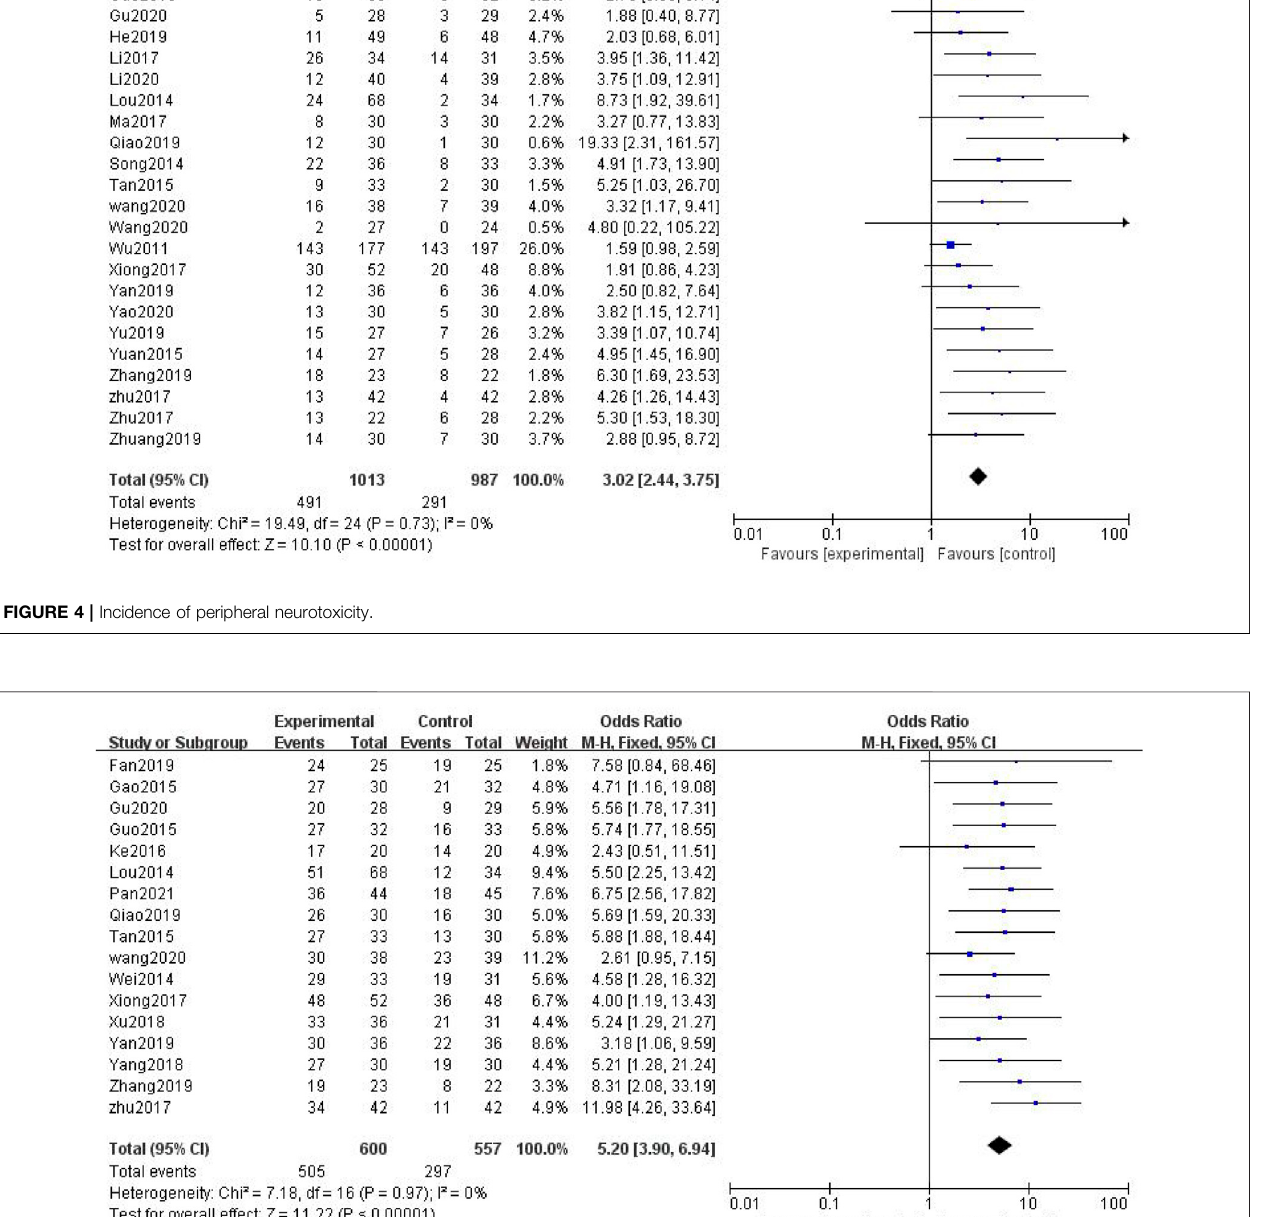
right sides were symmetric, indicating low publication bias. The results suggest that CHM external treatment decreased the incidence of peripheral neurotoxicity, increased clinical ef fi cacy, and improved quality of life in patients with CIPN.